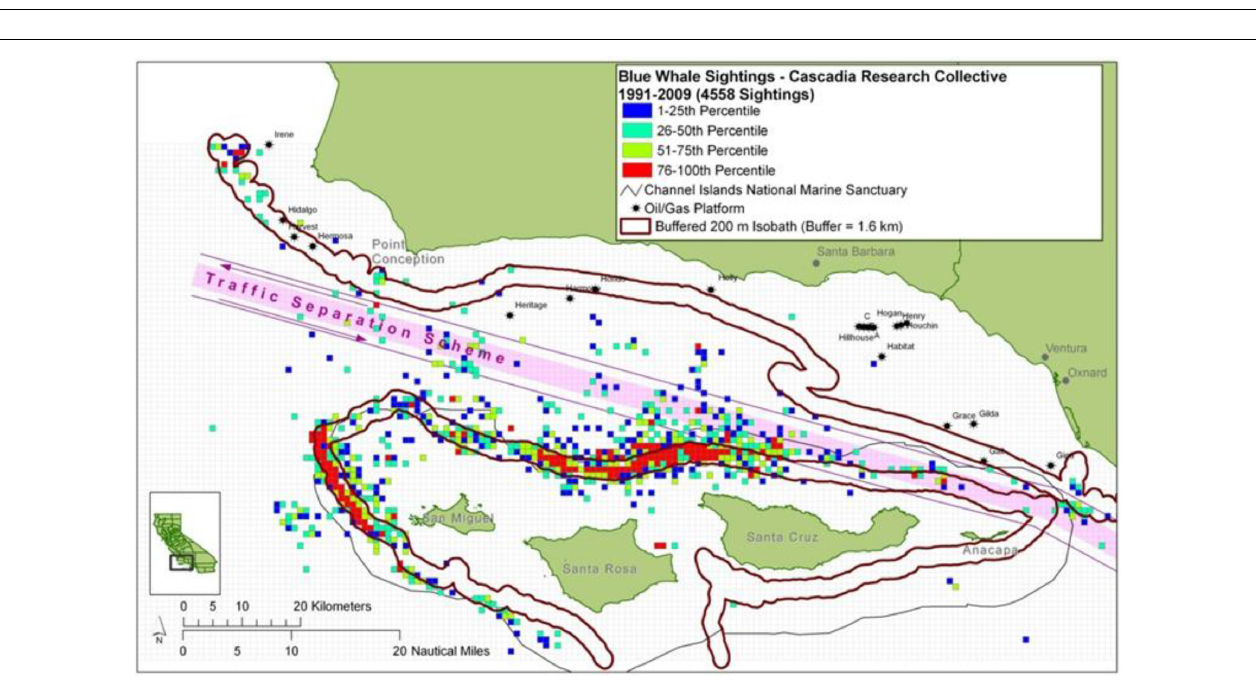
FIGURE 4 | Two examples of tracks of blue whales covering approximate 24-h periods with daytime tracks in white and nighttime in black showing movement patterns around Southern California shipping lanes (left in Santa Barbara Channel and right off LA/Long Beach). In both cases, long looping tracks were seen at night that took whales into or out of the shipping lanes (shown in red) compared to where they were feeding in the day.